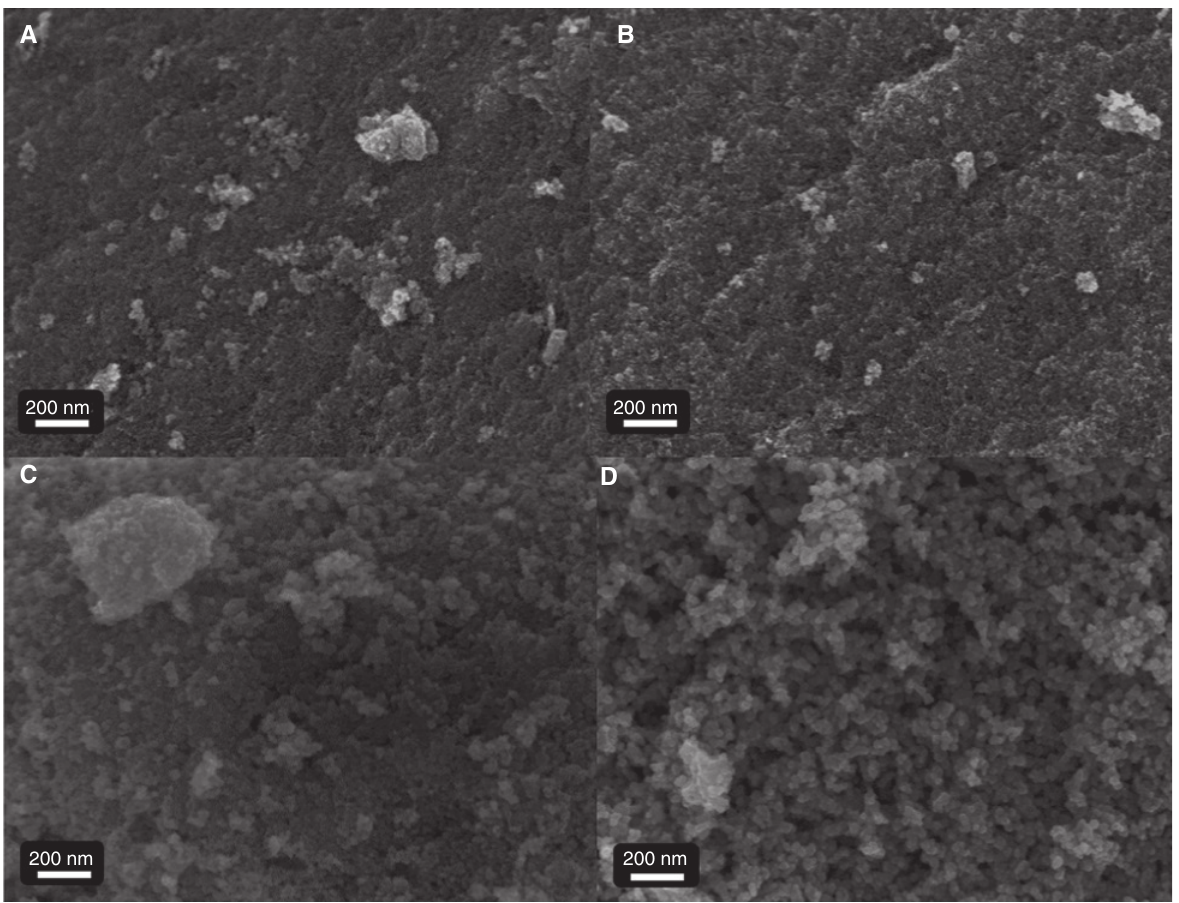
Figure 3: The FESEM images of the antimony-doped tin oxide (ATO) nanoparticles (NPs) (Sn/Sn + Sb = 15% at.) obtained with calcination temperatures: (A) as-synthesized, (B) 500 ° C, (C) 800 ° C, and (D) 1000 ° C.